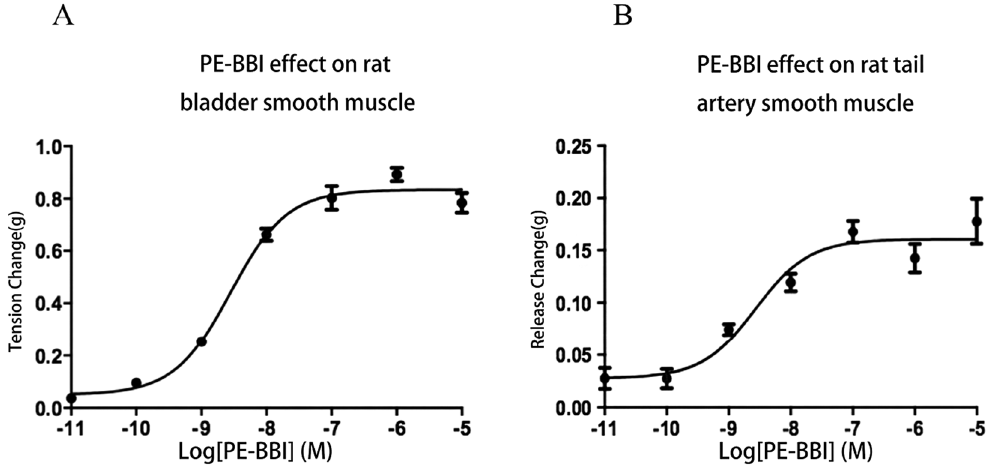
Figure 3. (A ) Dose-response contraction effect of synthetic PE-BBI on rat bladder smooth muscle preparations. ( B ) Dose-response release of PE-BBI on rat-tail artery smooth muscle preparations. Data points in each panel represent the mean and SD of values obtained for 5